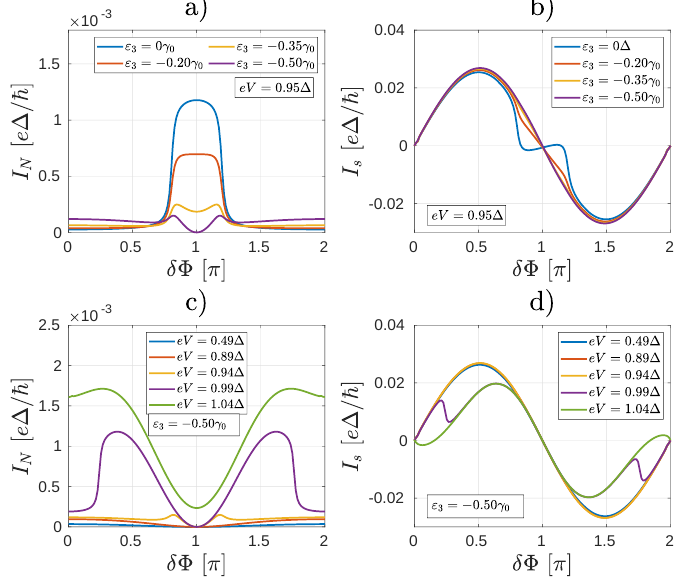
Figure 7. The currents ( a ) I N and ( b ) I s ( b ) as a function of the phase difference δ Φ between the superconducting leads for the system depicted in Figure 6a for several values of the on-site energy ε 3 and fixed bias eV = 0.95 ∆ . I N starts to show a double peak structure as a function of δ Φ for ε 3 ≈ − 0.20 γ 0 . ( c ) I N and ( d ) I s as a function of the bias voltage eV for ε 3 = − 0.50 γ 0